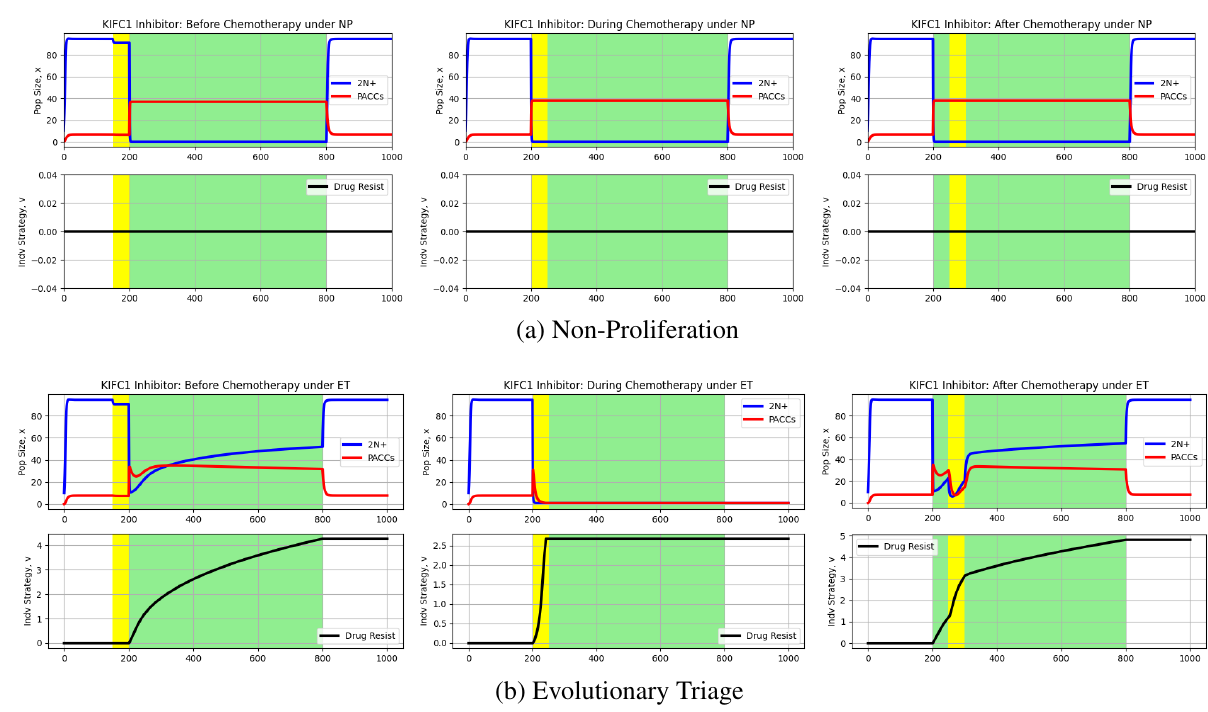
Figure 4. Effect of KIFC1 inhibitor on eco-evolutionary dynamics of cancer cell population. Blue and red curves depict 2N+ and PACC population dynamics, respectively, and the black curve captures the evolutionary dynamics of resistance. White and green backgrounds reflect periods without and periods with chemotherapy, respectively, and yellow backgrounds are periods with a KIFC1 inhibitor. Under ET, the KIFC1 inhibitor promoted extinction of the cancer cell population when administered at the same time as chemotherapy. Under NP, the KIFC1 inhibitor had little impact on 2N+ and PACC